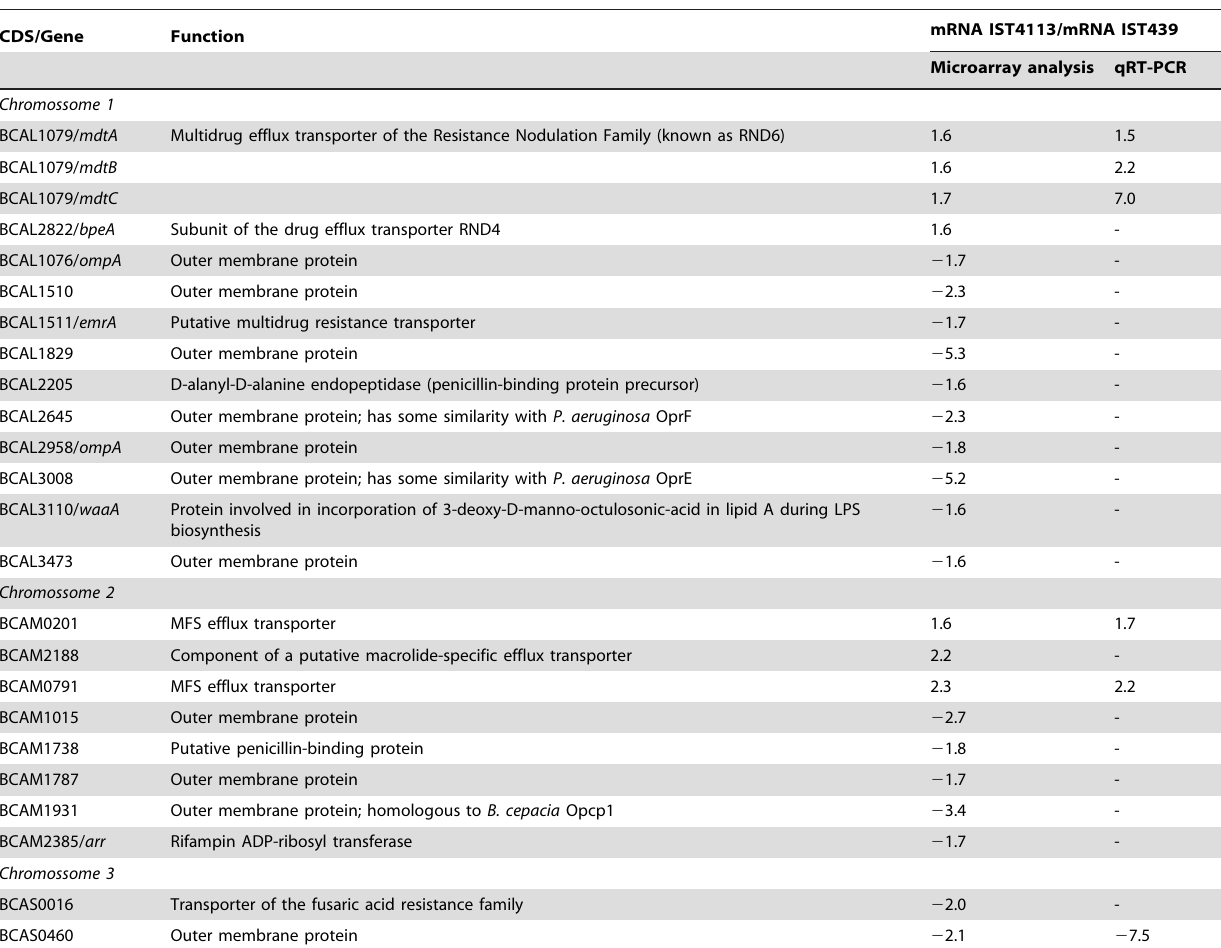
Table 2. Antibiotic resistance-genes differently transcribed in IST439 and IST4113.